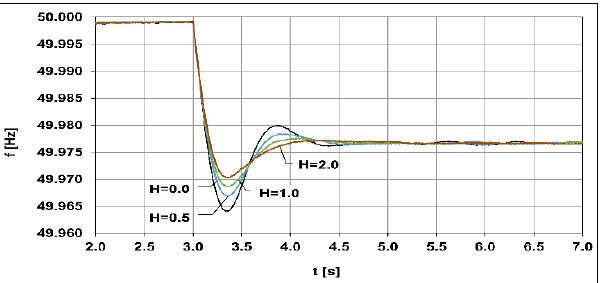
Figure 12. Frequency changes during load increase for selected inertia coefficients.